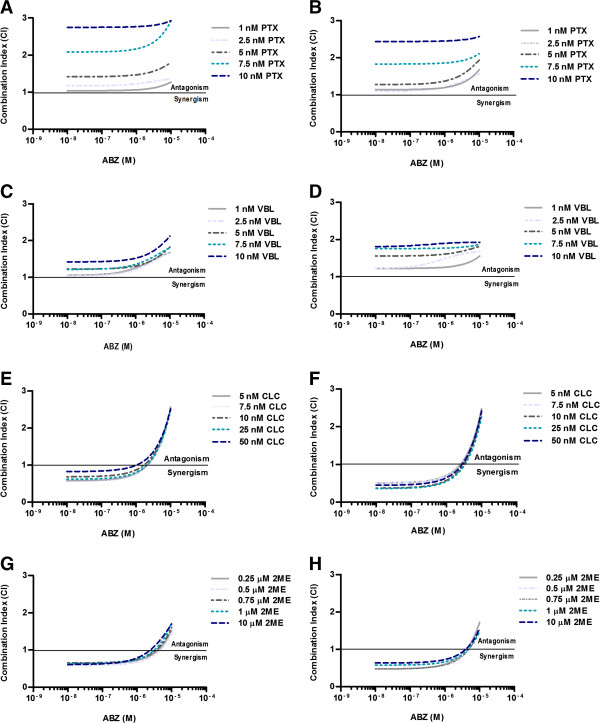
The effect of ABZ in combination with PTX (A,B), VBL (C,D), CLC (E,F), and 2ME (G,H) on HCT-116 (left panel) and DU145 cells (right panel). Cell viability was assessed by the SRB assay after 72 hours of simultaneous incubation with the drugs. Data were analyzed with Calcusyn software. CI < 1 indicates synergism, CI >1 indicates antagonism and CI = 1 shows additive effect.